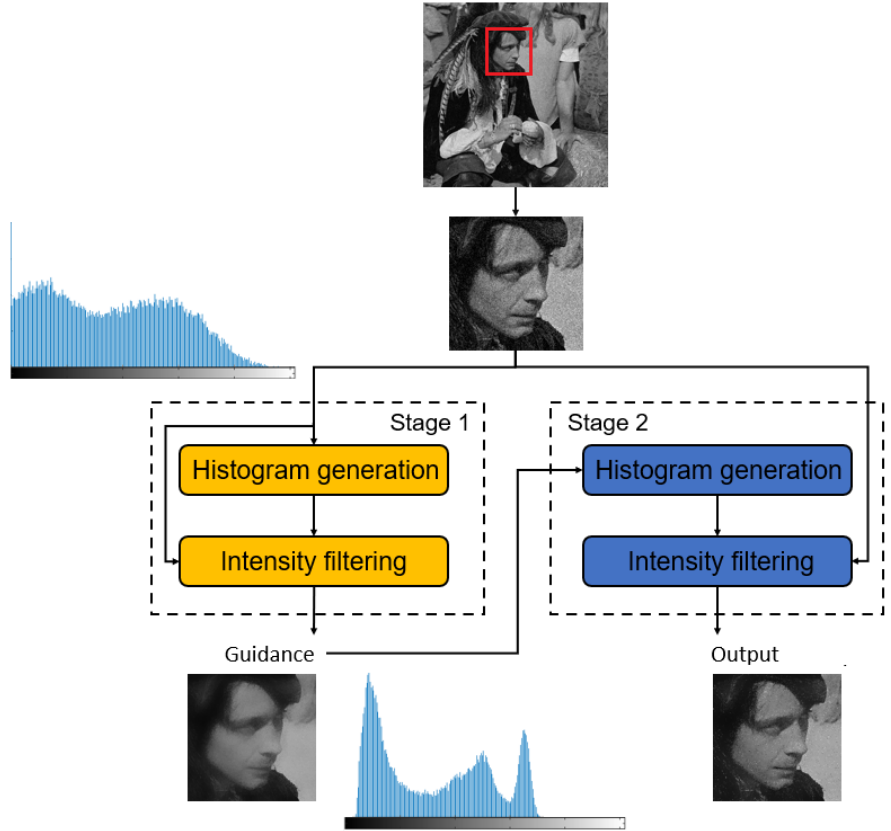
Figure 1. The flowchart of the DHBF